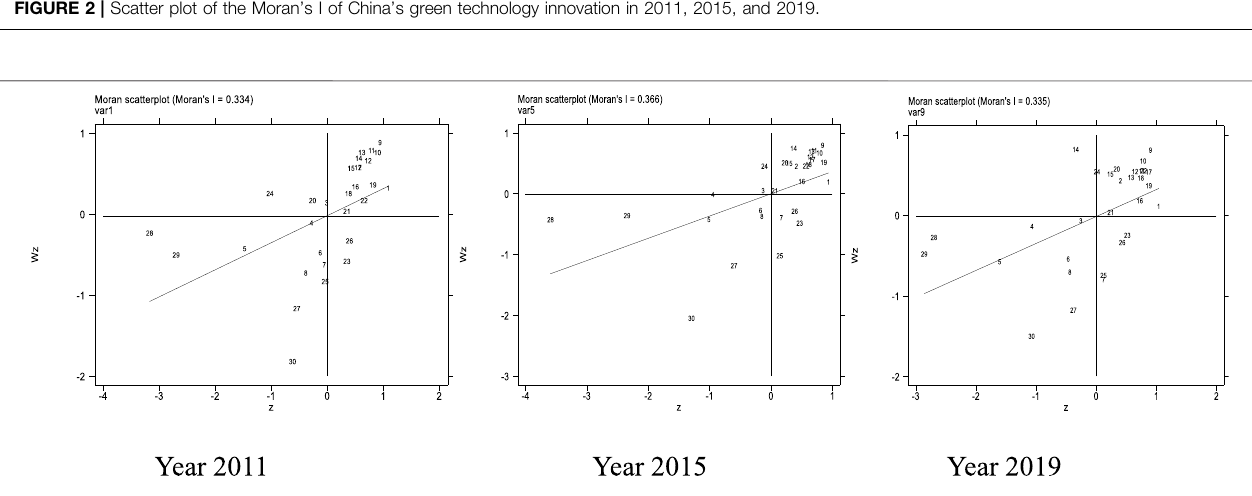
FIGURE 2 | Scatter plot of the Moran ’ s I of China ’ s green technology innovation in 2011, 2015, and 2019.